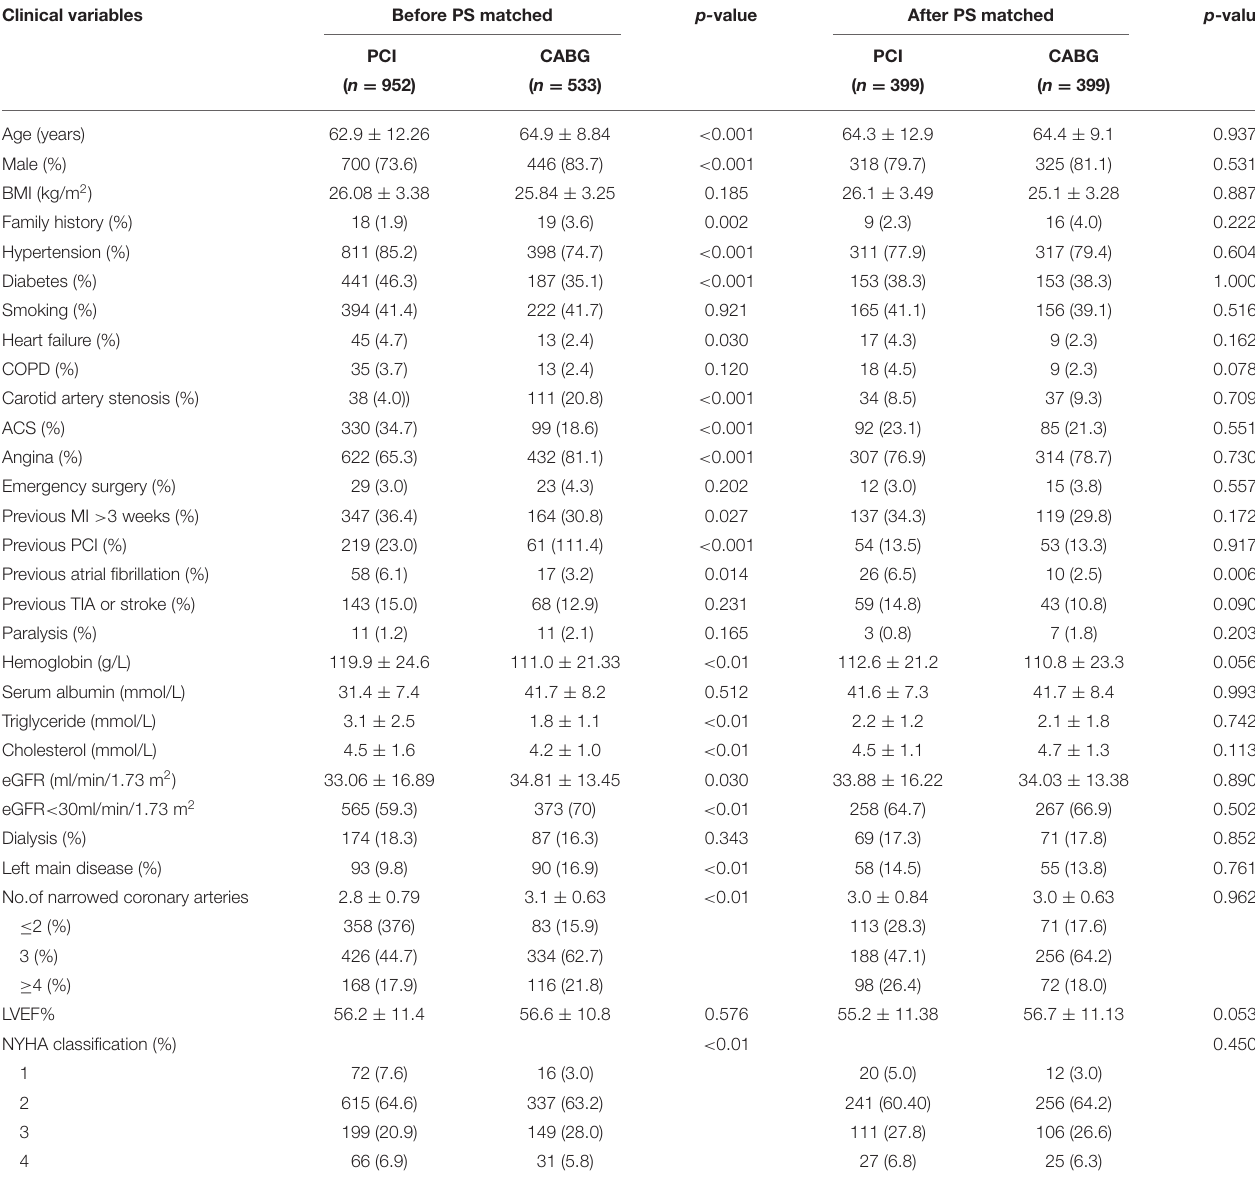
TABLE 1 | Comparison of preoperative baseline characteristics between CABG and PCI groups. Clinical